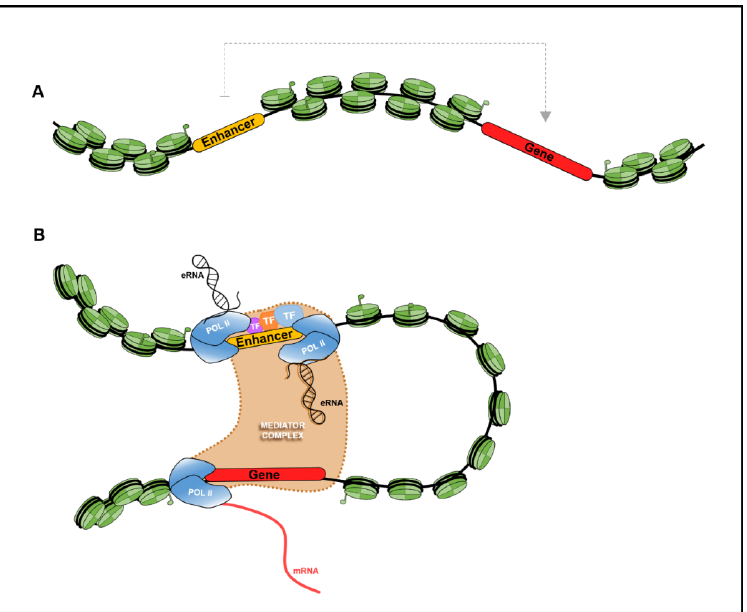
Figure 3. Model of enhancer RNA mechanism. ( A ) Enhancer and gene sequences in chromatin prior to gene activity. ( B ) Partially or fully assembled sets of TFs can associate with the enhancer and the gene promoter. In the active state, the enhancer and its transcript may physically associate with the gene, triggering formation of a mediator complex